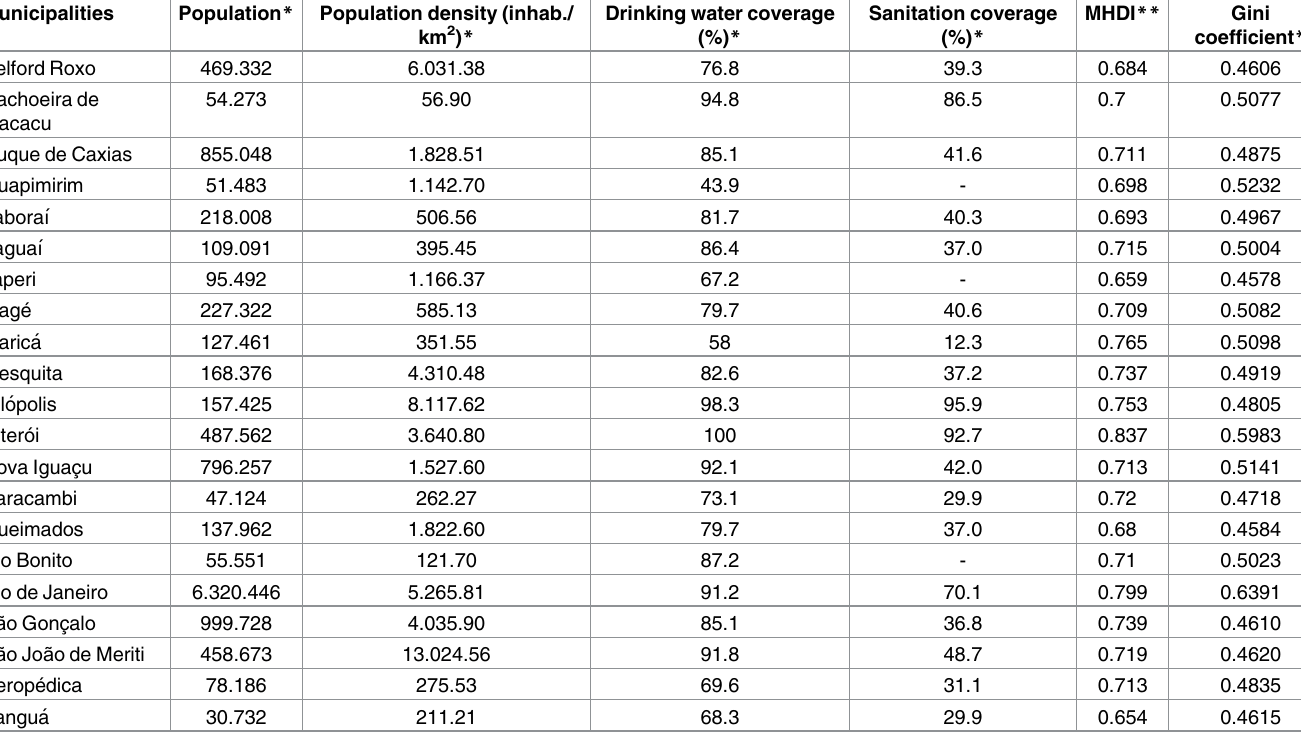
Table 1. Main characteristics of municipalities of the metropolitan region of Rio de Janeiro